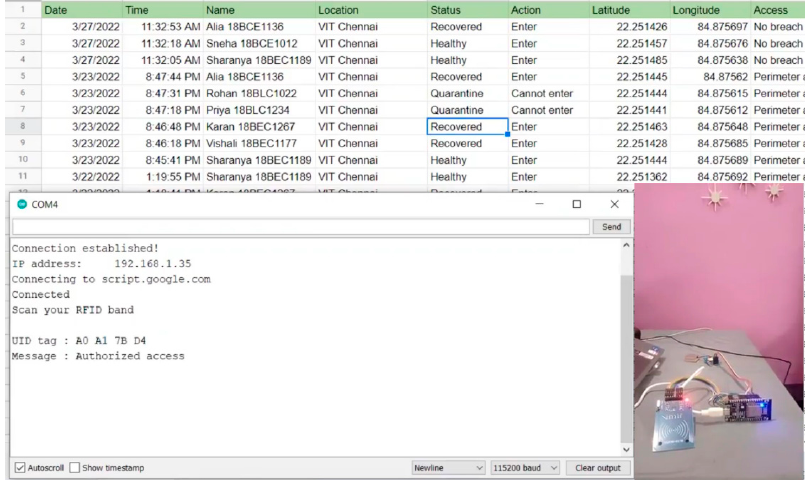
Figure 7. Experimental setup along with a status update in the COM port window and log screen .